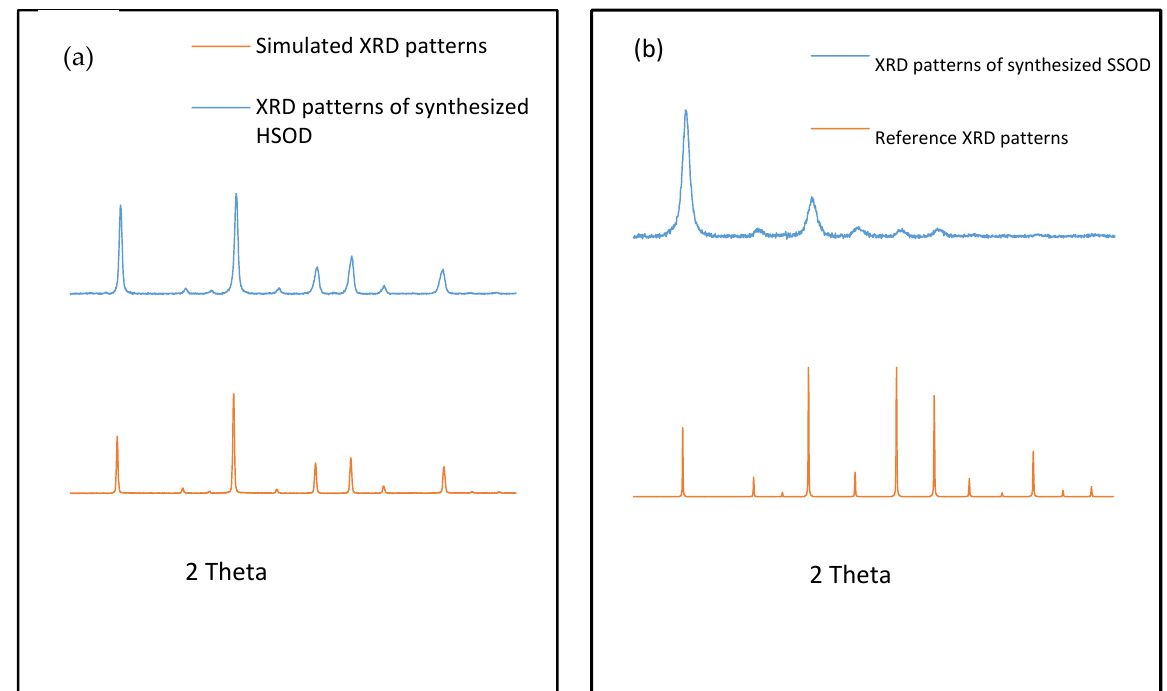
Figure 1. XRD patterns of ( a ) synthesized hydroxy sodalite (HSOD) and simulated XRD patterns, ( b ) synthesized silica sodalite (SSOD) XRD patterns and reference XRD patterns obtained from the International Zeolite Association (IZA) website [28].